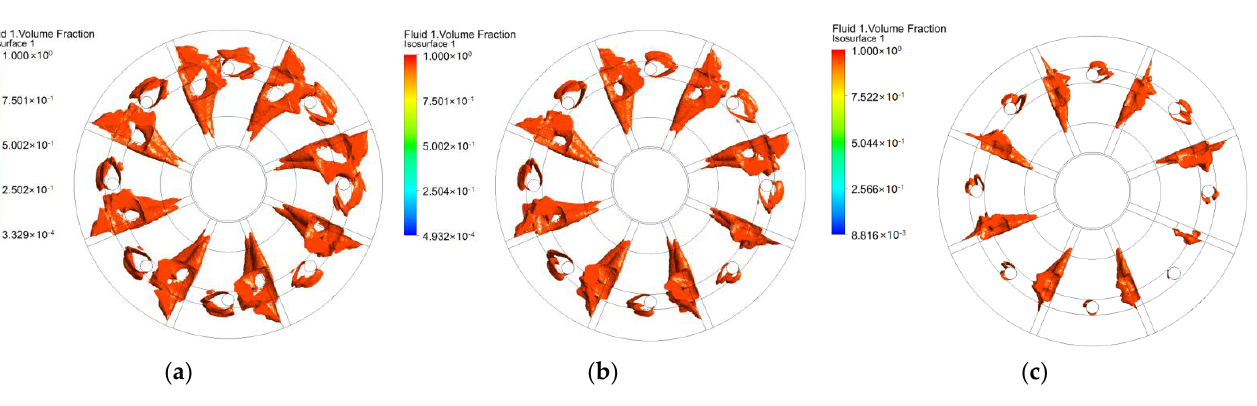
Figure 14. Distribution of cavitation inside the impeller under different inlet pressures of the blade disc pump (Q = 96.87 m 3